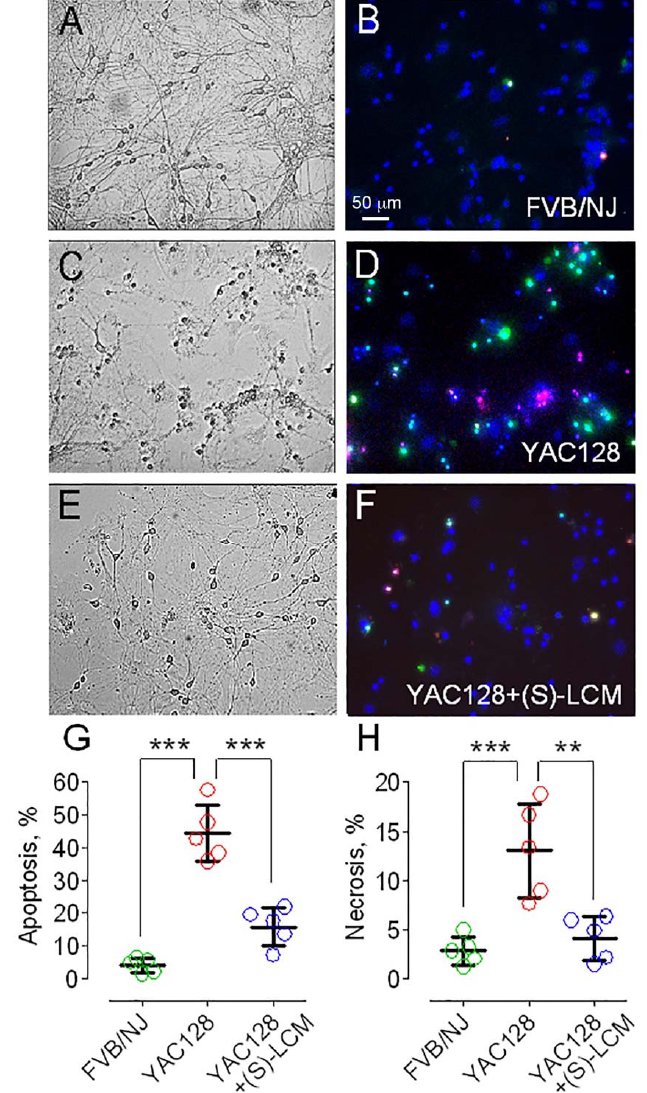
Figure 6. An evaluation of spontaneous necrotic and apoptotic cell death with Chromatin Conden- sation/Membrane Permeability/Dead Cell Apoptosis Kit (ThermoFisher Scientific, Cat #V23201), containing Hoechst 33342, YO-PRO-1, and propidium iodide (PI). Hoechst 33342 staining (blue flu- orescence) indicated live cells. Nuclei staining with PI (red fluorescence) is associated with the loss of barrier properties of the plasma membrane and is considered an indication of necrosis [61]. An induction of apoptosis was evaluated with YO-PRO-1 staining (green staining). These experiments were performed with cultured striatal neurons from FVB/NJ ( B ) and YAC128 ( D ) mice. (S)-lacosa- mide ((S)-LCM) protected neurons from cell death ( F ). Neurons were cultured for 21 days in vitro (21 DIV). ( A , C ), phase contrast bright field images of cultured striatal neurons from FVB/NJ and YAC128 mice, respectively. ( E ), phase contrast bright field image of (S)-LCM-treated cultured stria- tal neurons from YAC128 mice. ( G , H ), quantification of apoptotic cell death and necrotic cell death, respectively. Neurons were treated with 10 µM of (S)-LCM for the last 14 days prior to cell death analysis. Data are mean ± SD. ** p < 0.01, *** p < 0.001 comparing FVB/NJ neurons and YAC128 neurons; comparing YAC128 neurons with and without (S)-LCM treatment, N = 5 separate, inde- pendent experiments.